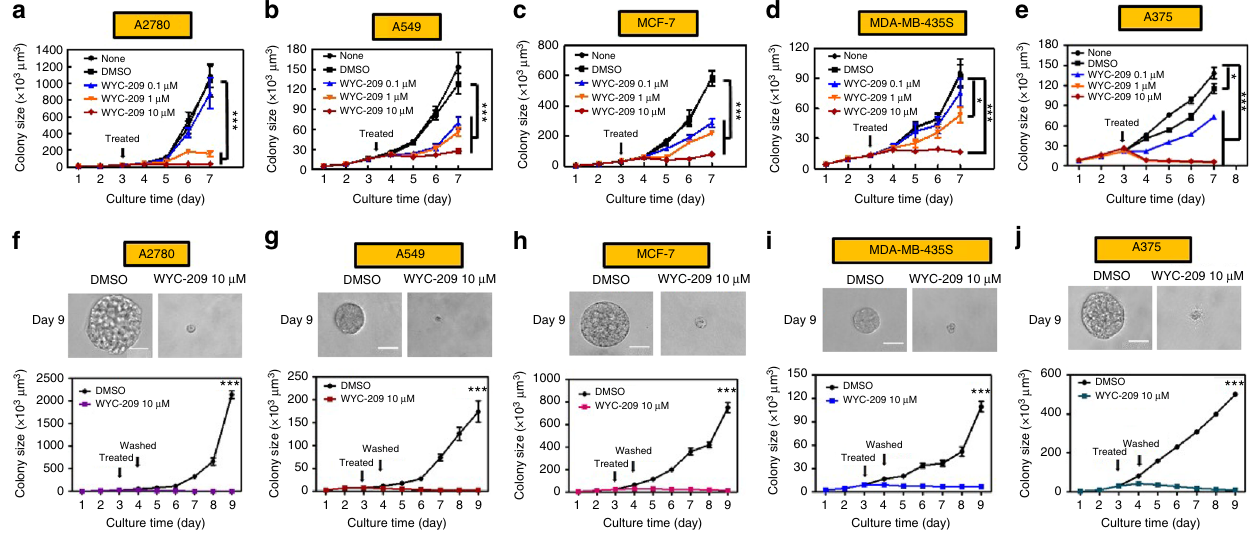
Fig. 4 WYC-209 inhibits colony growth of fi ve different human cancer lines. Human ovarian cancer A2780 ( a ), human lung cancer A549 ( b ), human breast cancer MCF-7 ( c ), human melanoma MDA-MB-435s ( d ), and human malignant melanoma A375 ( e ) were cultured in 90-Pa fi brin gels for 3 days and treated with 0.1, 1, or 10 μ M WYC-209. f – j A2780, A549, MCF-7, MDA-MB-435s, and A375 were cultured in 90-Pa fi brin gels for 3 days, treated with 10 μ M WYC-209, and were then washed out of the compound on day 4. None: cell medium only, DMSO: medium with 0.1% DMSO. Note that because the cell doubling time was different for different types of cancer cells, the colony sizes varied. Mean ± s.e.m.; n = 15 samples; three separate experiments; * P